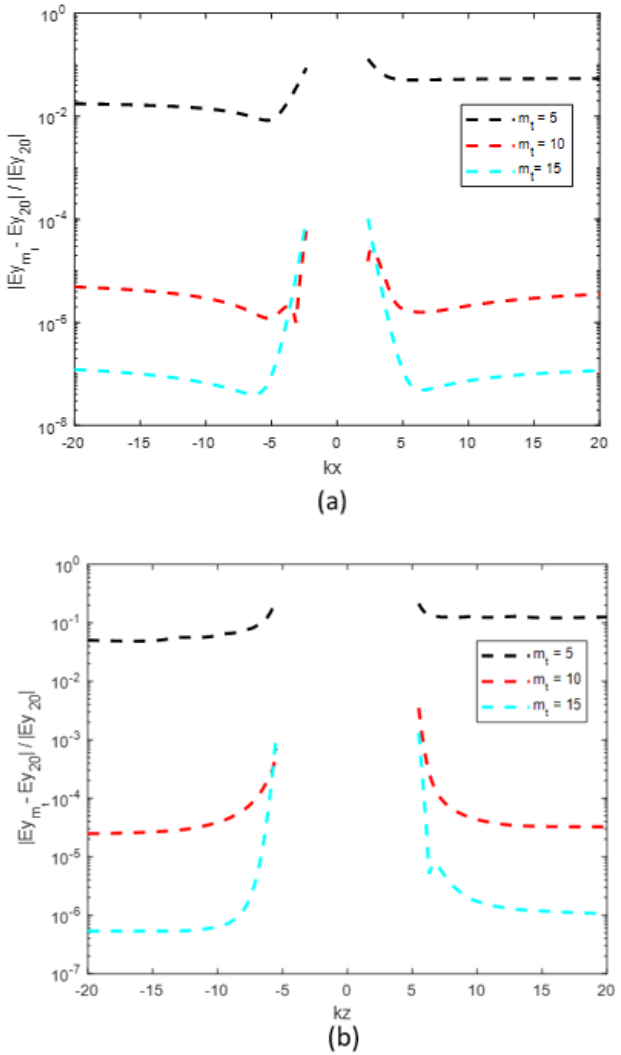
Figure 5. Validation of the truncation method. Comparison between the results obtained with m t = 5, m t = 10, and m t = 15, to those obtained with m t = 20: ( a ) relative error along the x -axis; ( b ) relative error along the z -axis. TE